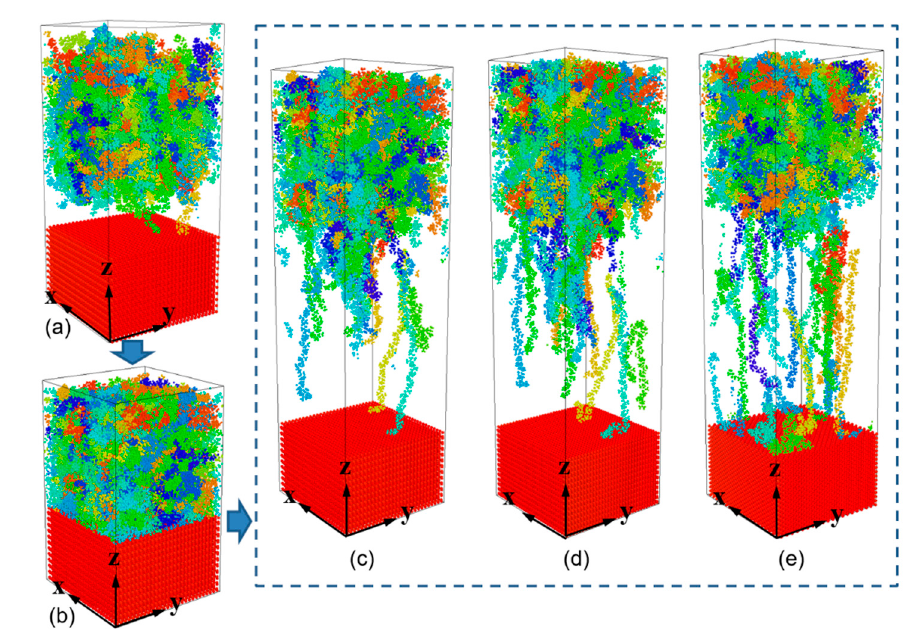
Figure 9. Snapshots of PP-metal hybrid structure during the injection molding and separation process. ( a ) the original PP-metal layer is constructed and then ( b ) injection-molded to form a hybrid system. After cooling process, an external force was applied to remove the PP layer away from the metal substrate. These snapshots are taken at a separation time of 10 ps, with the substrates of ( c ) Al, ( d ) Ni and ( e ) Fe, respectively.